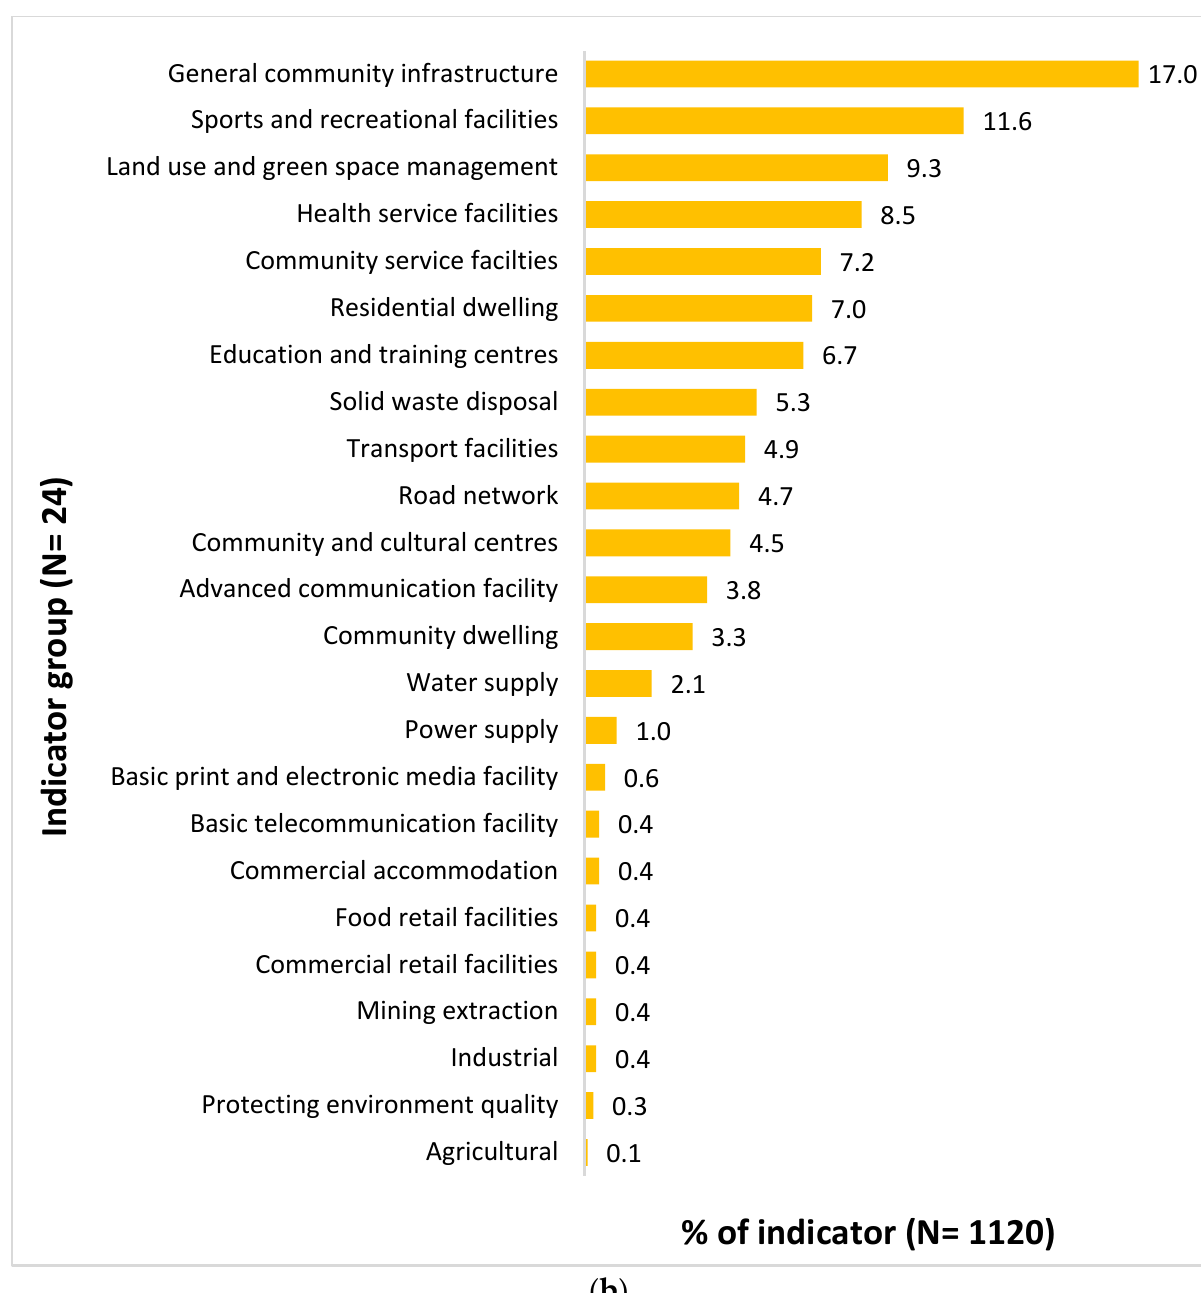
Figure 4. ( a ) Distribution of indicators by indicator group for the socio-political environmental subject group; ( b ) distribution of indicators by indicator groups for the built environmental subject group.